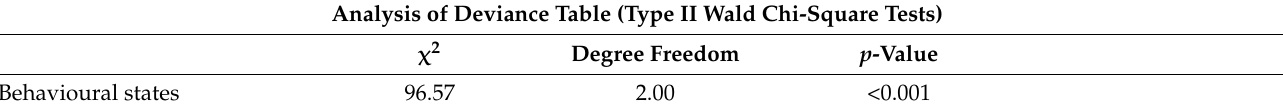
Table 2. Result of Generalized Linear Mixed Model on emission rate among Contact (C), Moving (M), and Still (S) behavioural states including the trials as the random effect.